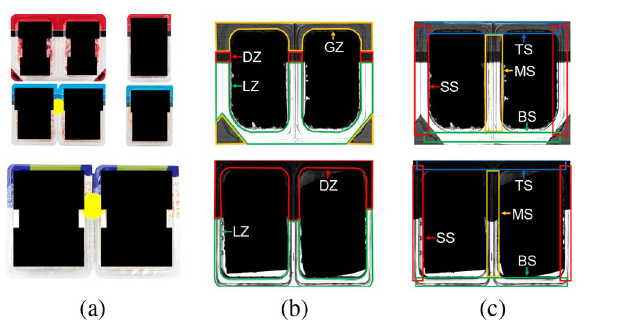
Figure 3. Sealing zones for all products: ( a ) products of different brands in bi-pack and single format; ( b ) light (LZ), dark (DZ) and gray zones (GZ), common to all packages; and ( c ) sealing zones according to the position, including top (TS), bottom (BS), side (SS) and middle sealing